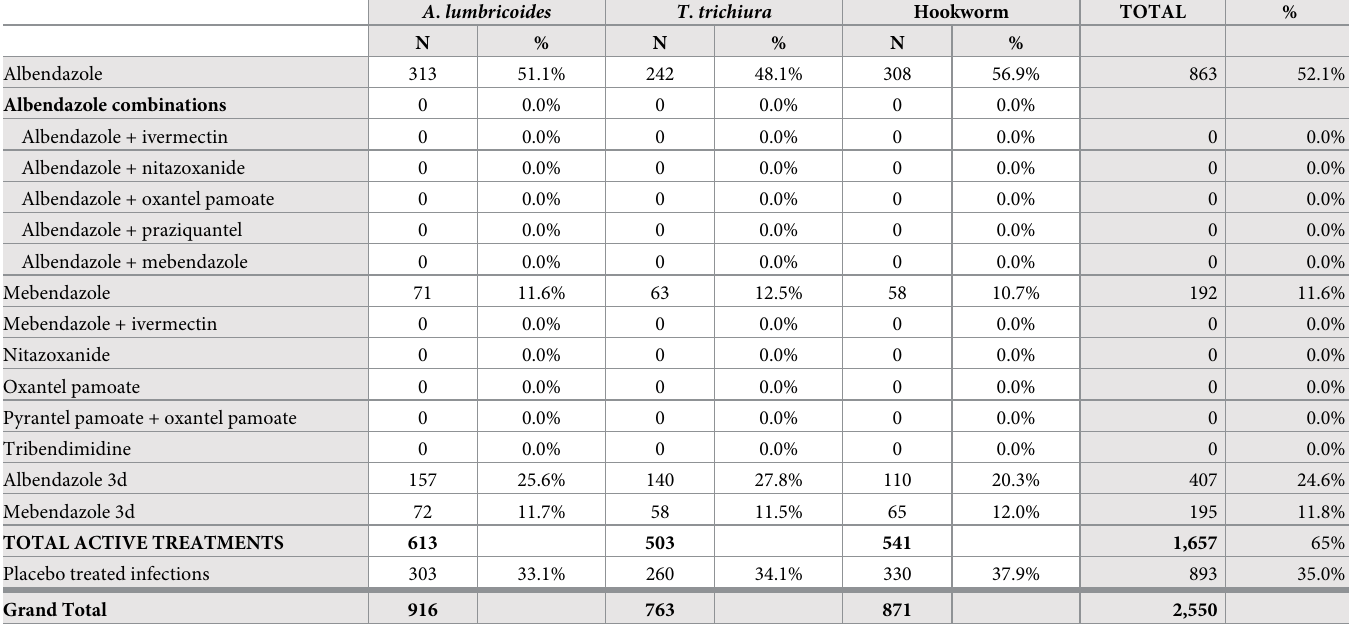
Table 3. Breakdown by treatment and species for follow-up at 22–45